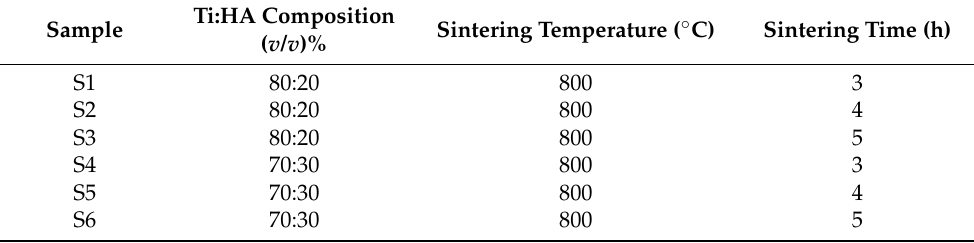
Table 1. Samples of varying Ti:HA compositions and their holding times of